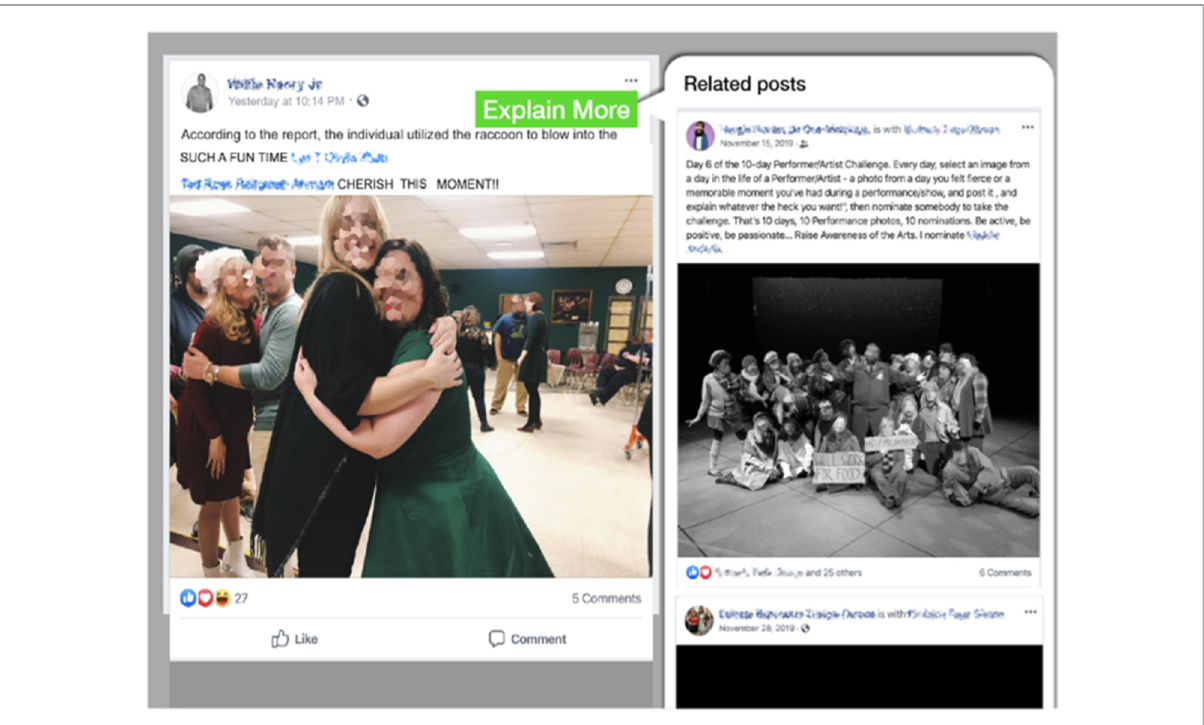
FIGURE 2 An example of the modi fi ed Facebook page using the memory aid. Identifying information such as names and faces have been blurred to protect con fi dentiality.